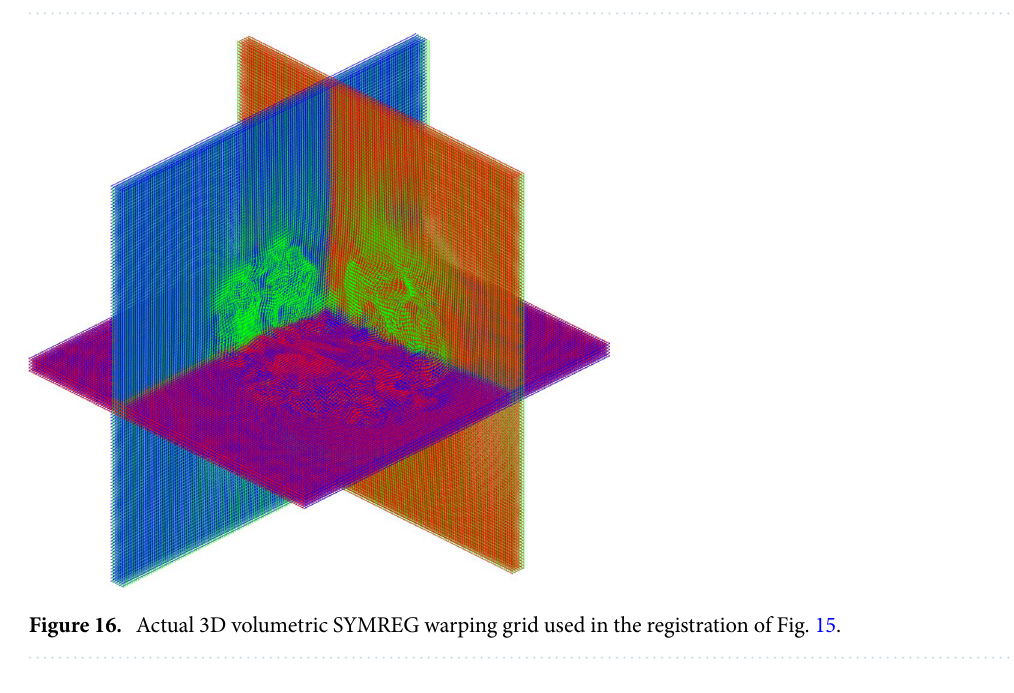
Figure 15. Registration of multiple high resolution anatomical (HRA) MRI scans using symplectomorphic registration (SYMREG). ( A ) Single reference HRA, ( B ) average of HRA datasets from 10 different people. Blurring is do to subtle natural shape variations between individual subjects ( C ) average of 10 images in ( B ) after registration with template image in ( A ) from (adapted from 43 ).